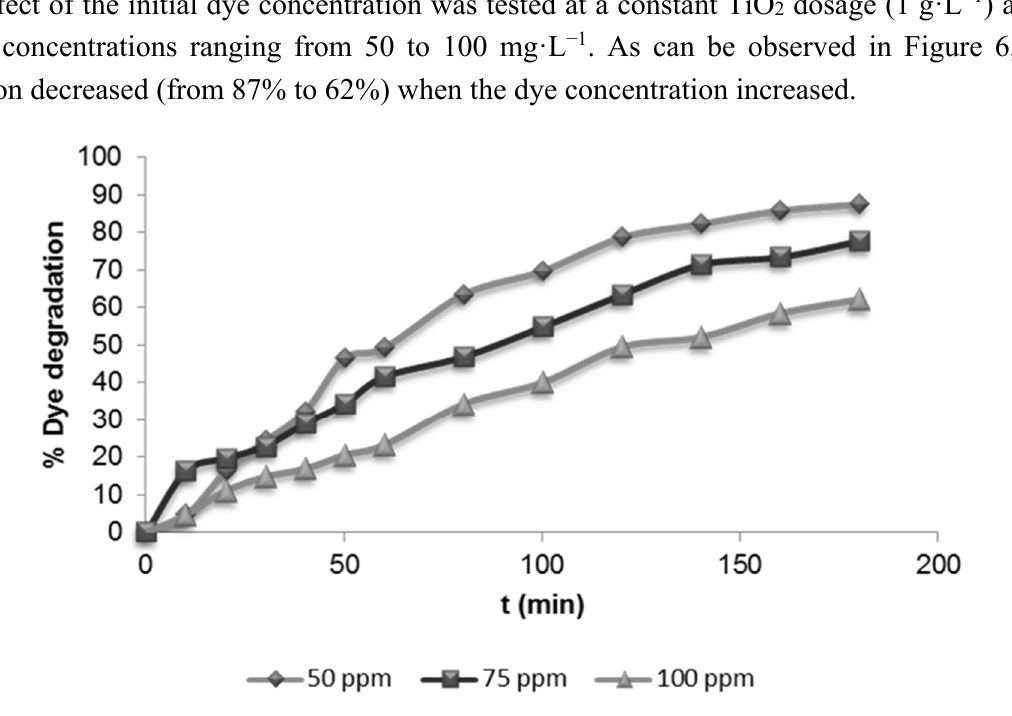
Figure 6. Influence of the initial dye concentration on dye degradation (1 g·L − 1 TiO 2